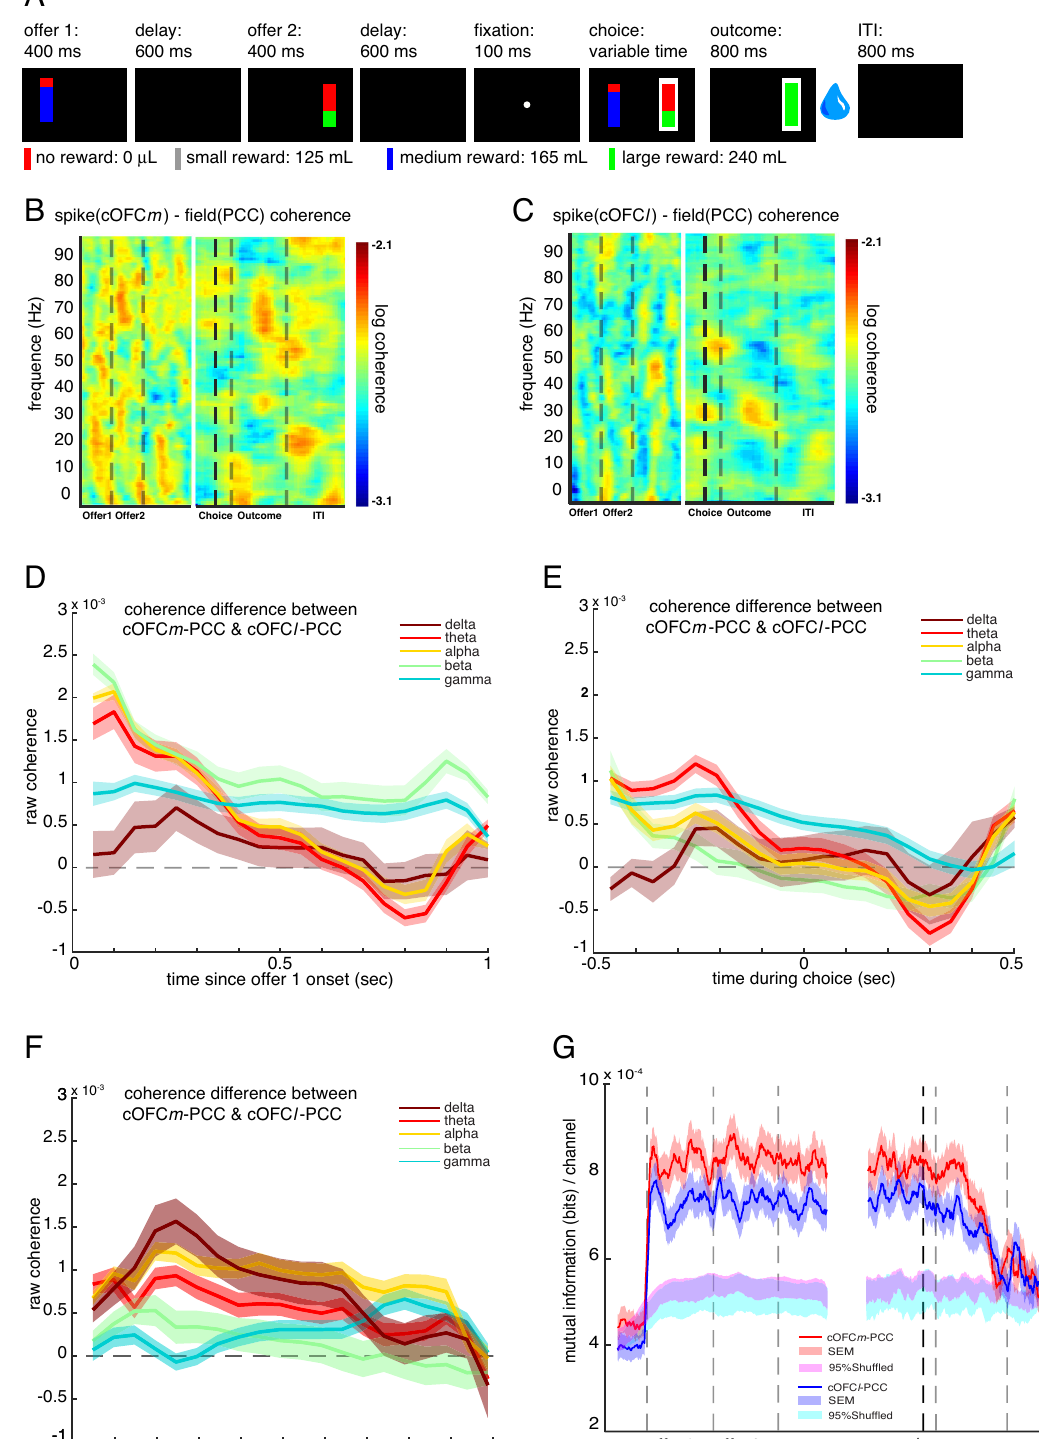
either comparison (respectively: r = 0.078, p = 0.578) and r = 0.224, p = 0.104). The corresponding data in PCC resembled the patterns in cOFC m for the fi rst comparison, although not for the second ( r = 0.271, p < 0.001; r = 0.065, p = 0.344). Overall, these results highlight the differences between cOFCl and cOFCm, speci fi cally, that the putative neural correlate of value comparison is observed in the medial area, but not detected in the lateral